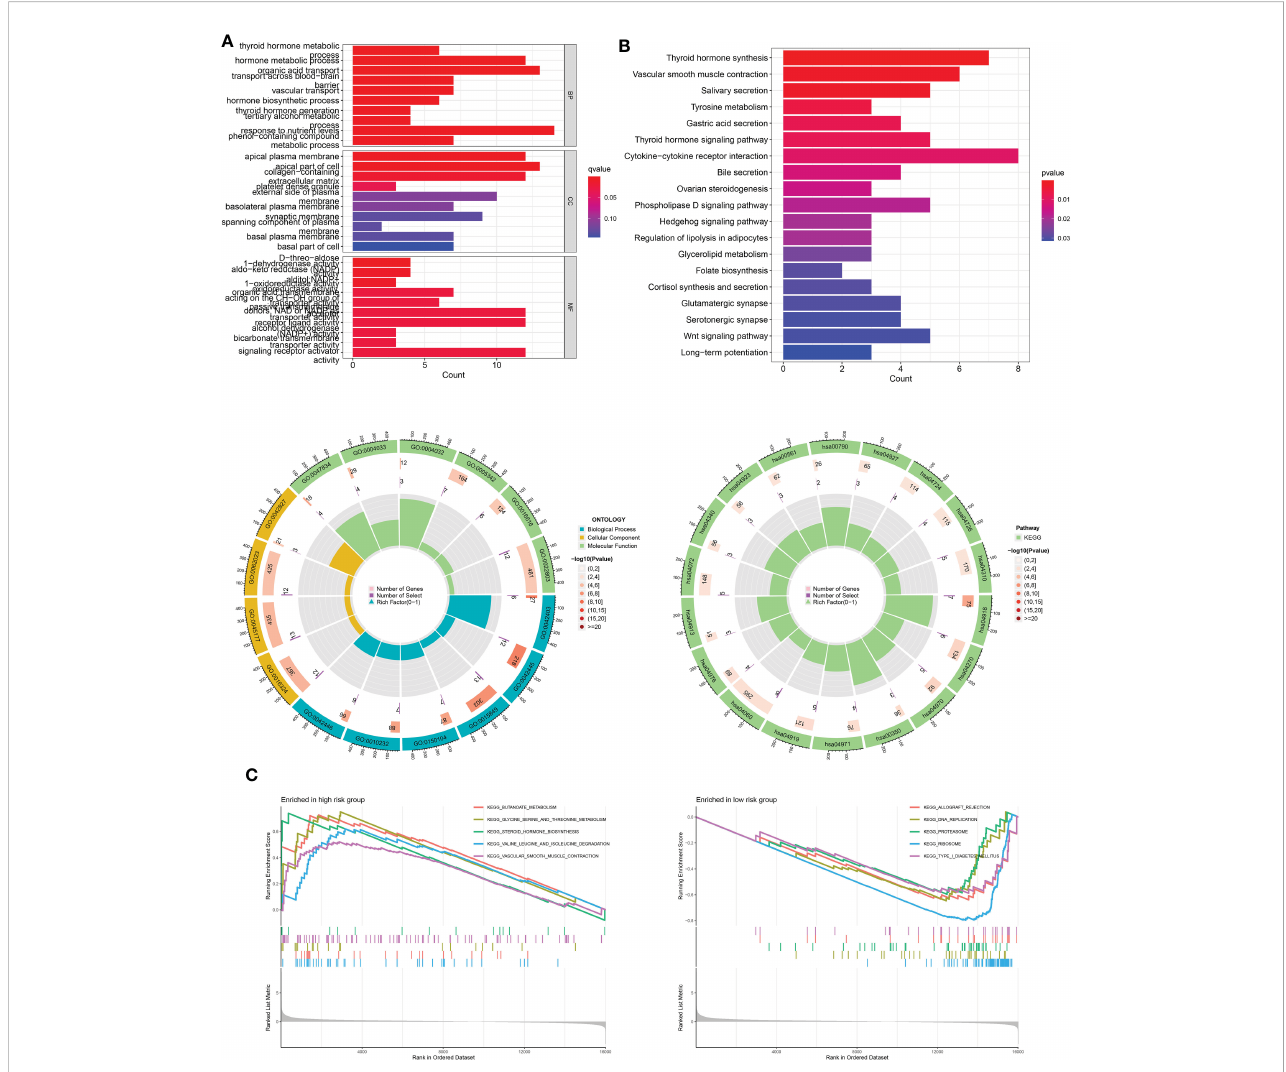
FIGURE 9 Functional enrichment analysis of low- and high-risk THCA. (A) GO enrichment results across TCGA-THCA including BP, CC, and MF analysis. (B) KEGG enrichment results showing the top related pathways across TCGA-THCA. (C) GSEA identifying the top fi ve gene sets in low- and high-risk